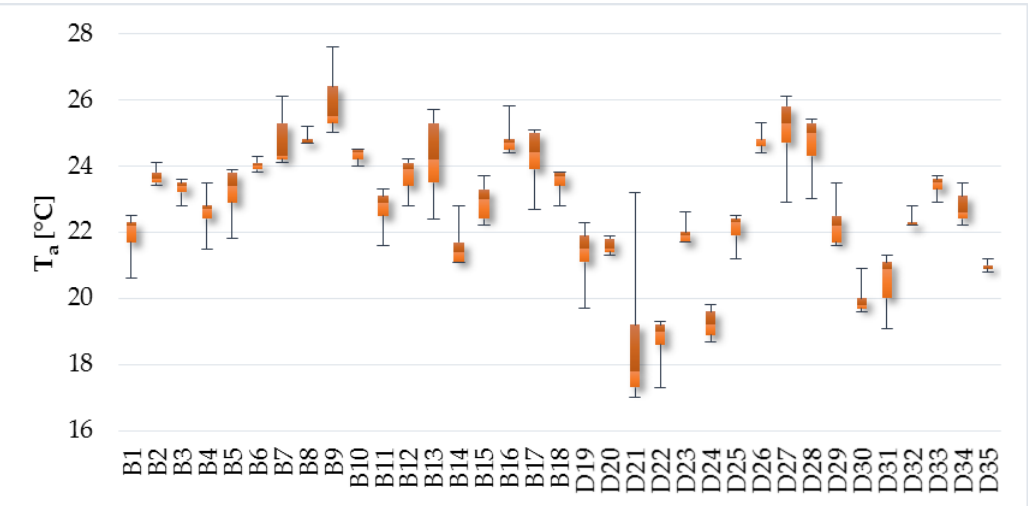
Figure 4. Indoor air temperature. Int. J. Environ. Res. Public Health 2017 , 14 , 1443